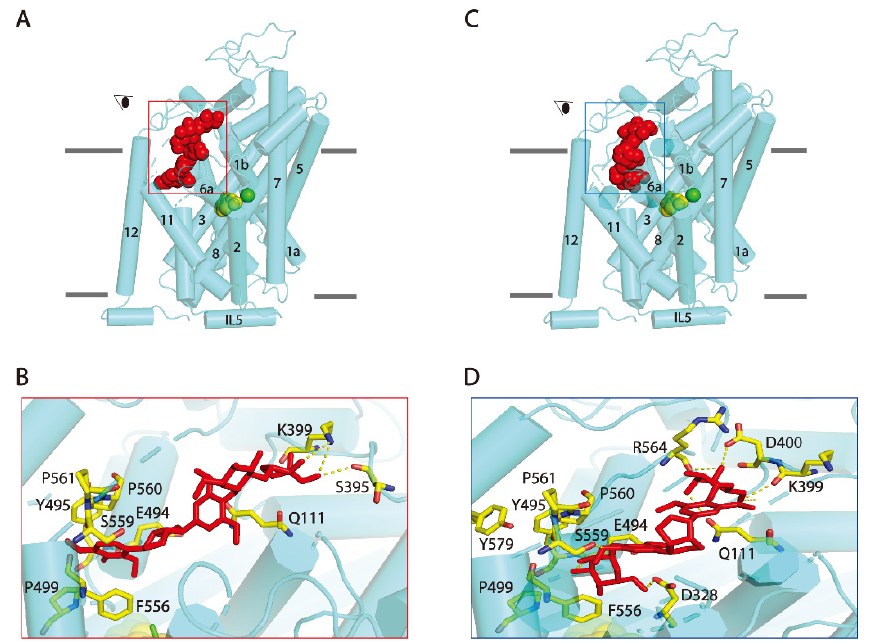
Figure 7. Molecular docking of SERT with SAG and SBG. Overall views of ( A ) SERT:SAG:5-HT and ( C ) SERT:SBG:5-HT complexes in cartoon representation. SAG (red) and 5-HT in central binding site (green and yellow) depicted as spheres. Separate green sphere represents Cl − ion. The eye represents the angle views depicted in ( B ) and ( D ), respectively. ( B , D ) Close-ups of proposed SAG or SBG binding in the S2 site. Residues that interacted with SAG or SBG are annotated and shown in yellow sticks. IL: intracellular loop.